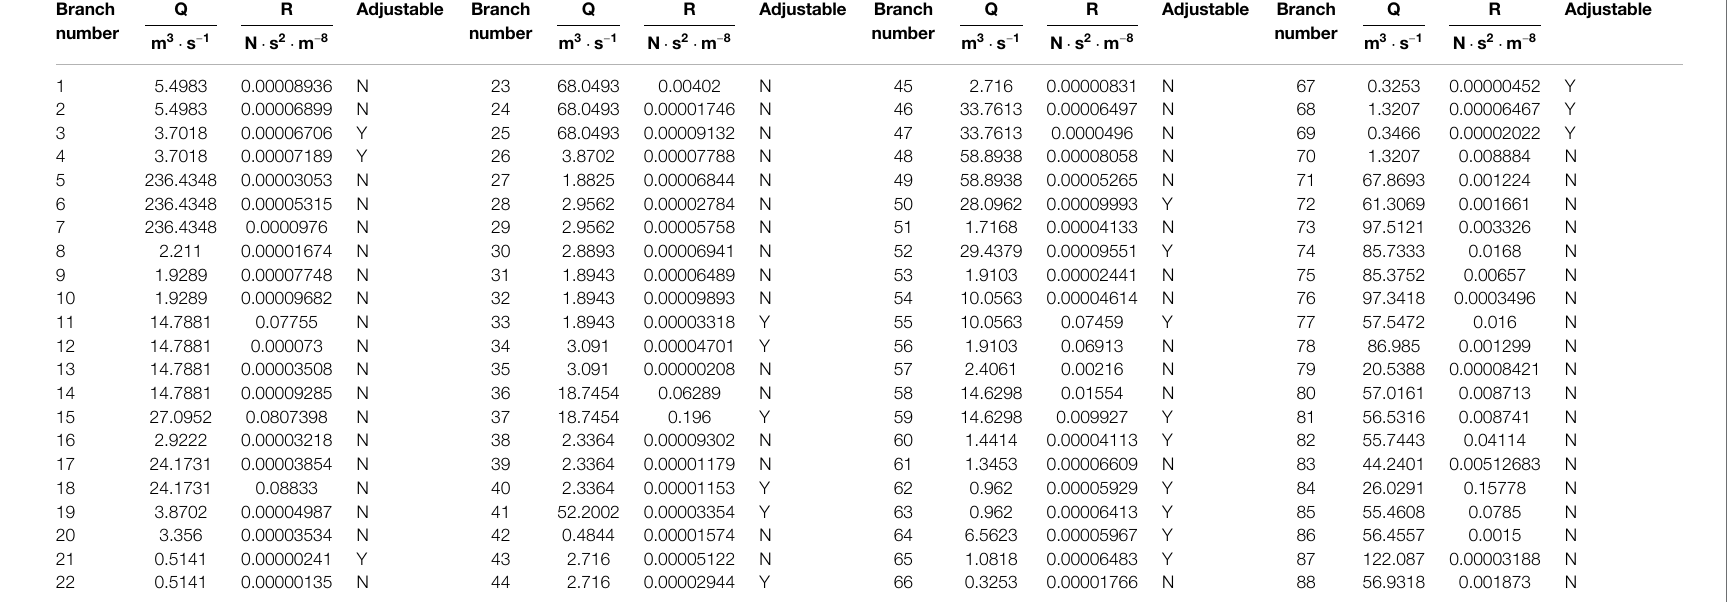
TABLE 4 | Air resistance quantity of some